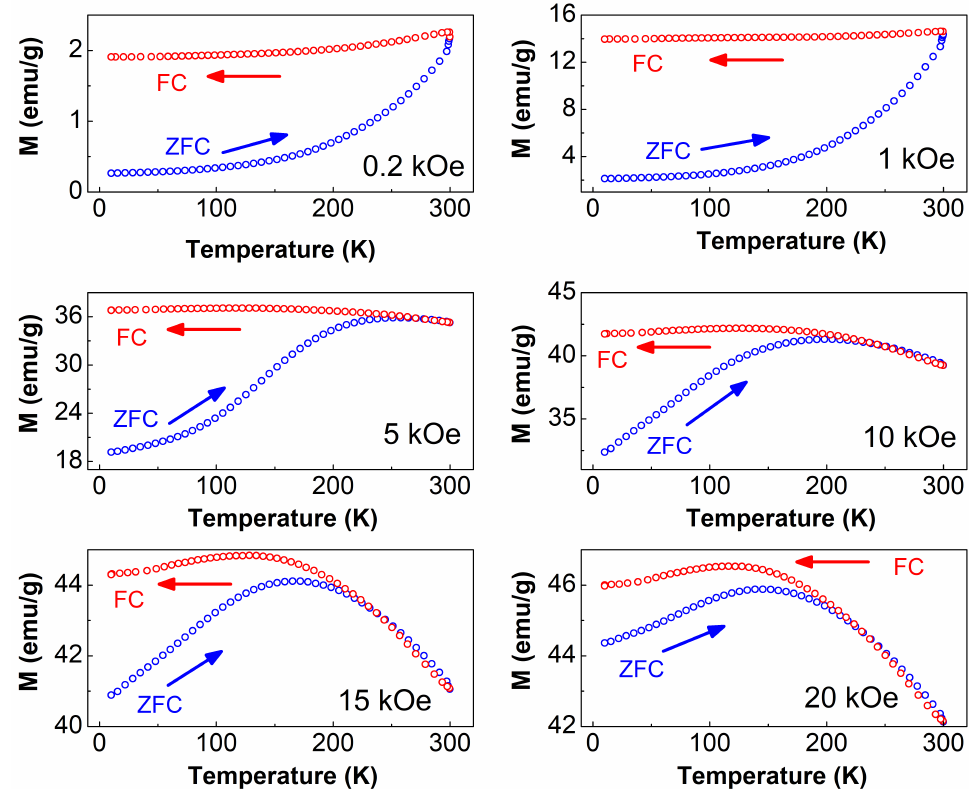
Figure 6. ZFC–FC magnetization curves of the Cu 0.75 Co 0.25 Fe 2 O 4 nanoparticles recorded at different applied magnetic